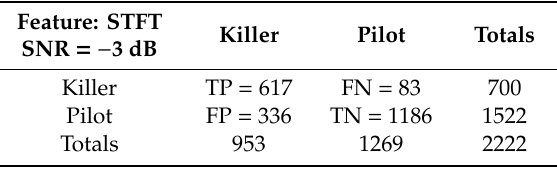
Table 12. Classification results: STFT, SNR = − 3 dB.